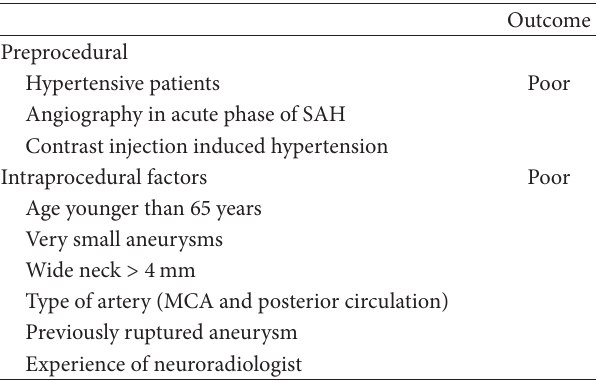
Table 2: Intraoperative variables contributing intracranial aneu- rysm rupture (coiling